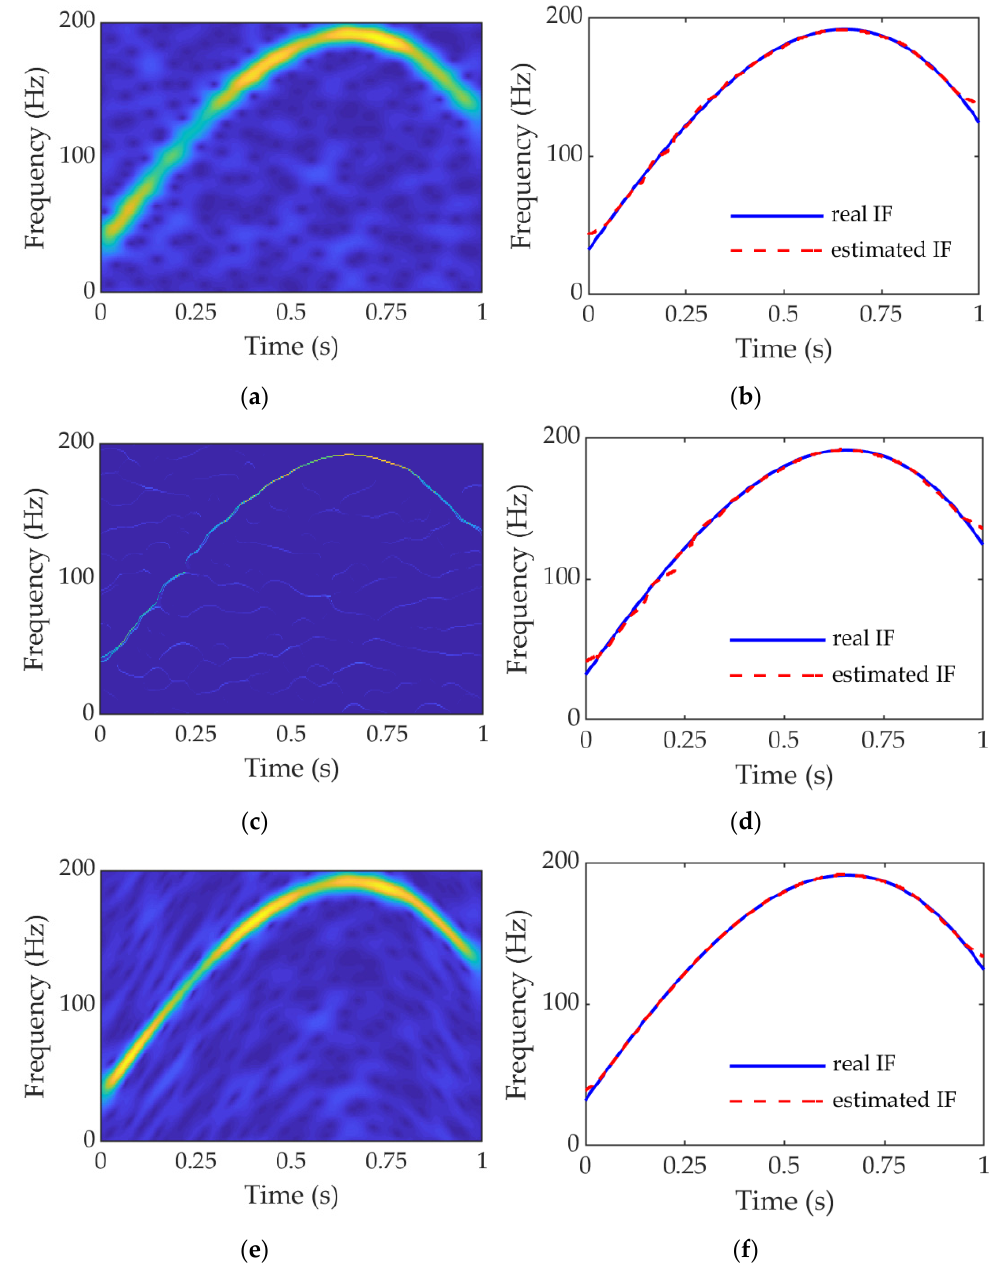
Figure 4. ( a ) The TFR generated by the STFT; ( b ) the estimated IF compared with the real IF (MAPE = 1.48%); ( c ) the TFR generated by the IMSST; ( d ) the estimated IF compared with the real IF (MAPE = 1.55%); ( e ) the TFR generated by the PCT; and ( f ) the estimated IF compared with the real IF (MAPE = 0.73%).